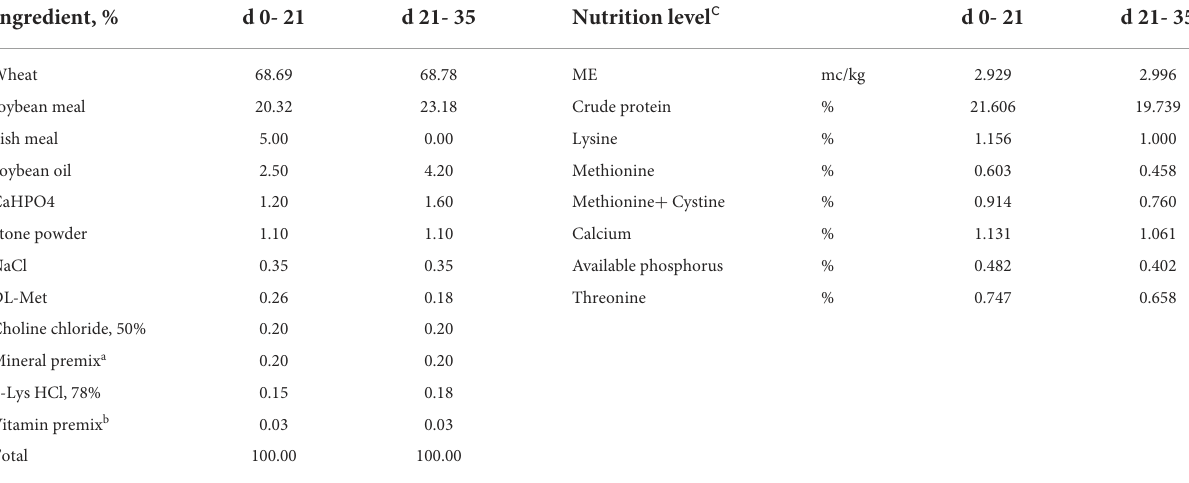
TABLE 1 The feed ingredient composition and nutrient levels, air-dried basis.